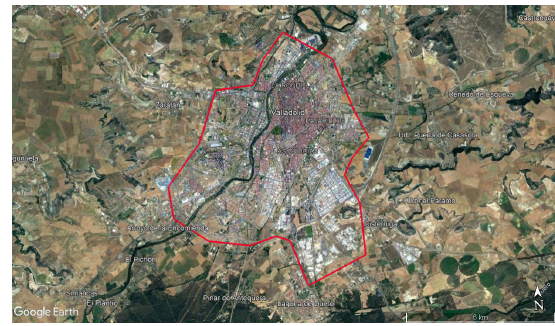
Figure 1. Area included in the